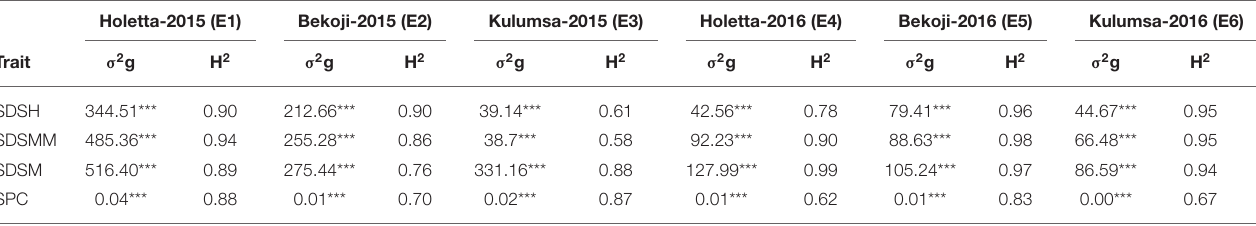
TABLE 2 | Genotypic variance ( σ 2 g) and heritability in the broad sense (H 2 ) for phenotypic traits in 180 bread wheat genotypes in six different environments in Ethiopia. Holetta-2015 (E1) Trait